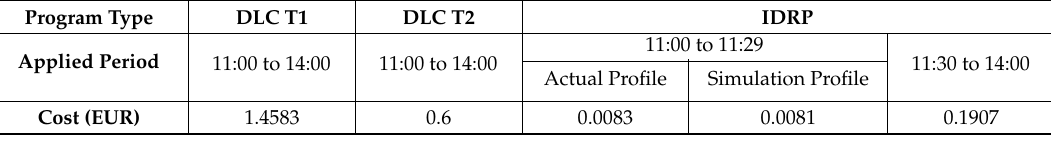
Table 3. Remuneration costs for each program paid by the aggregator to DR